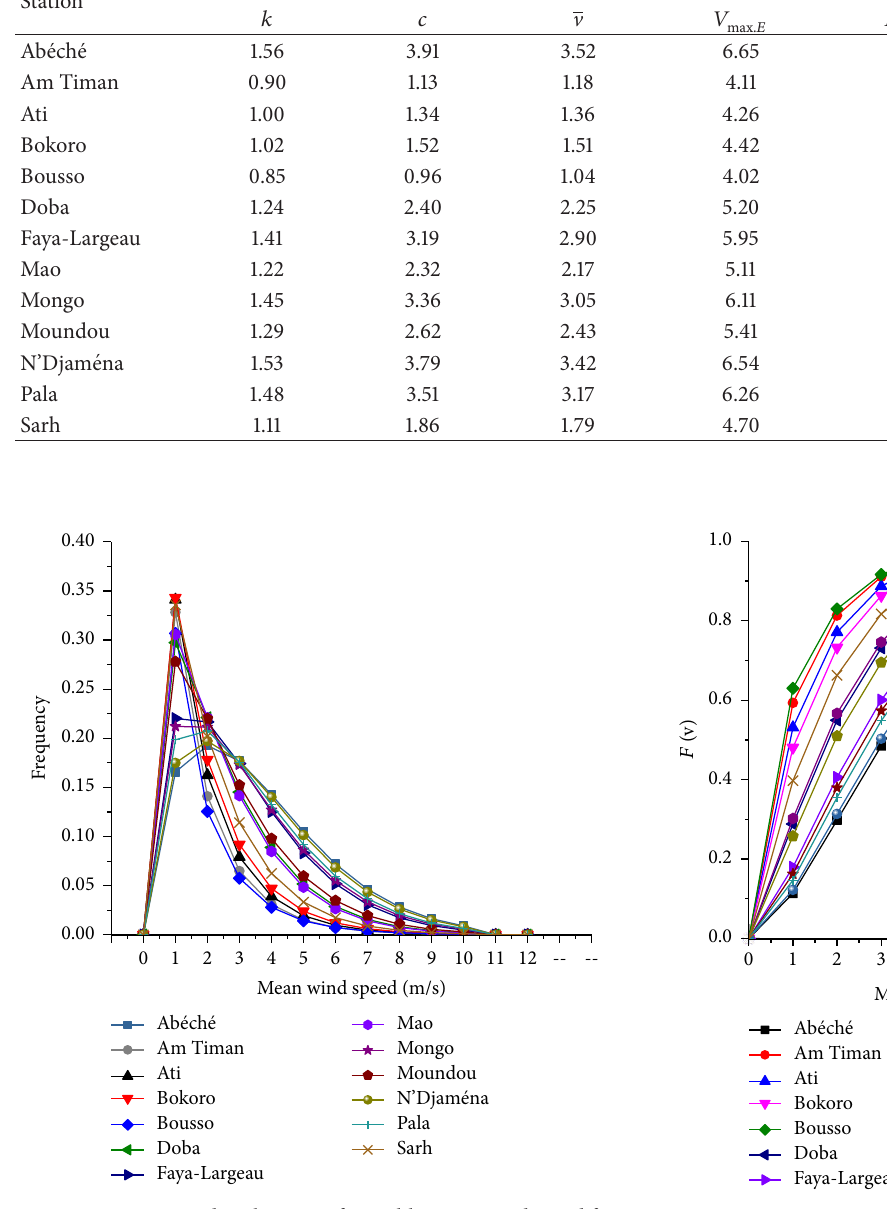
Figure 5: Frequency distributions of monthly mean wind speed for all stations.